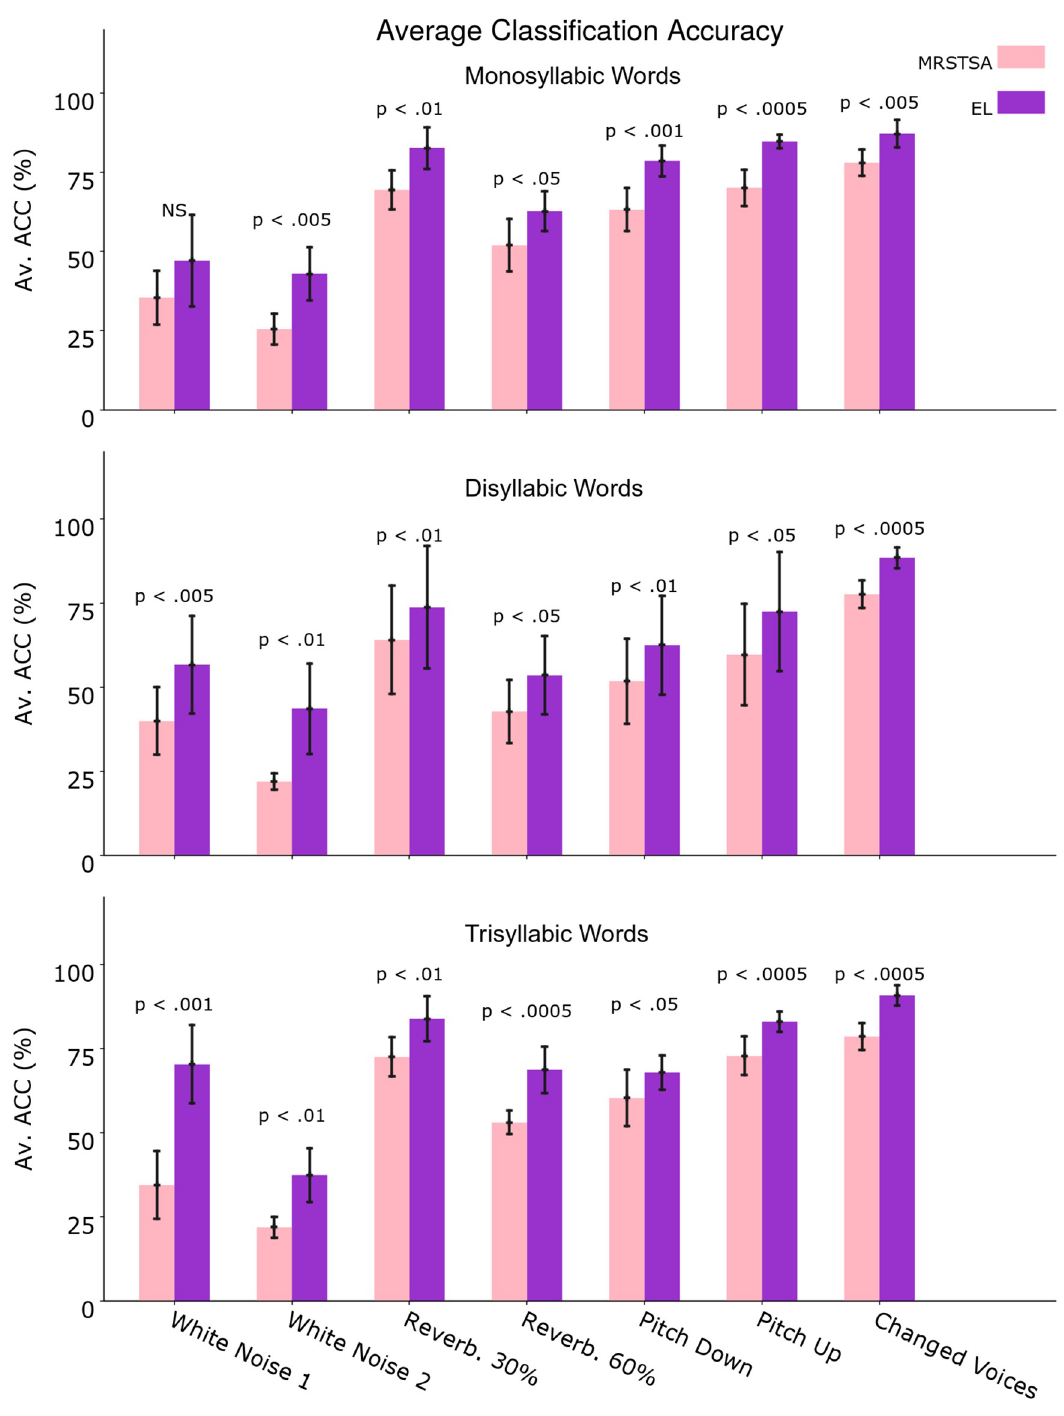
Fig 9. MRSTSA and EL average classification accuracies against different acoustic variants introduced to the signals for monosyllabic, disyllabic and trisyllabic words. White Noise 1 determines a SNR average RMS power rate of 19.8 dB while White Noise 2 13.8 dB. Reverberation 30% determines a RT-60 value of 0.61 seconds while Reverberation 60% determines a RT-60 value of 1.78 seconds. Pitch Up determines a pitch move from E to G, while Pitch Down determines a pitch move from E to C. Changed Voices corresponds to corpora generated using a different set of voices from the one used to train the ELs and the classifiers. Error bars depict 95% Confidence Interval values. The p values correspond to two-tailed paired t-tests and NS stands for Not Statistically